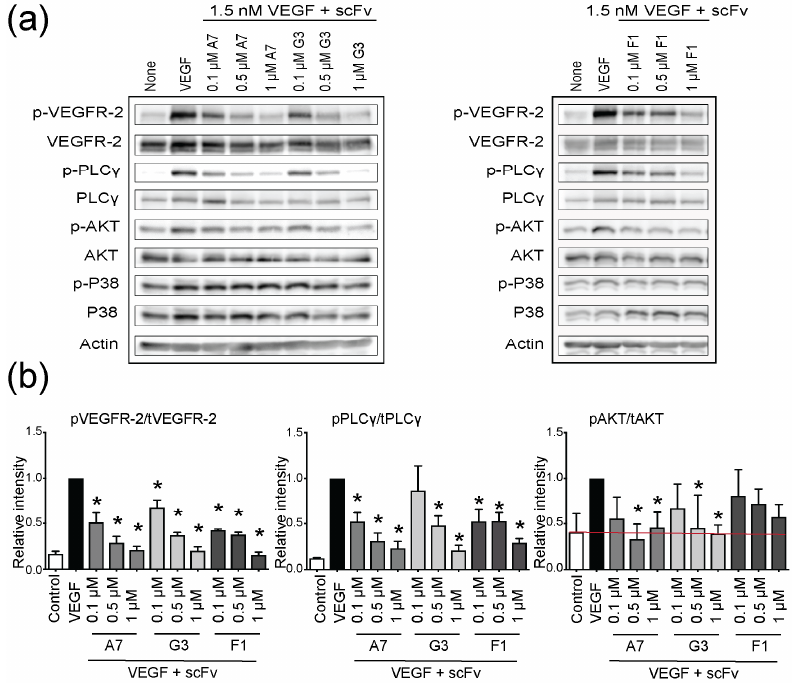
Figure 3. ScFvs inhibit VEGF-induced signaling in PAE-KDR cells. ( a ) Western blot results show